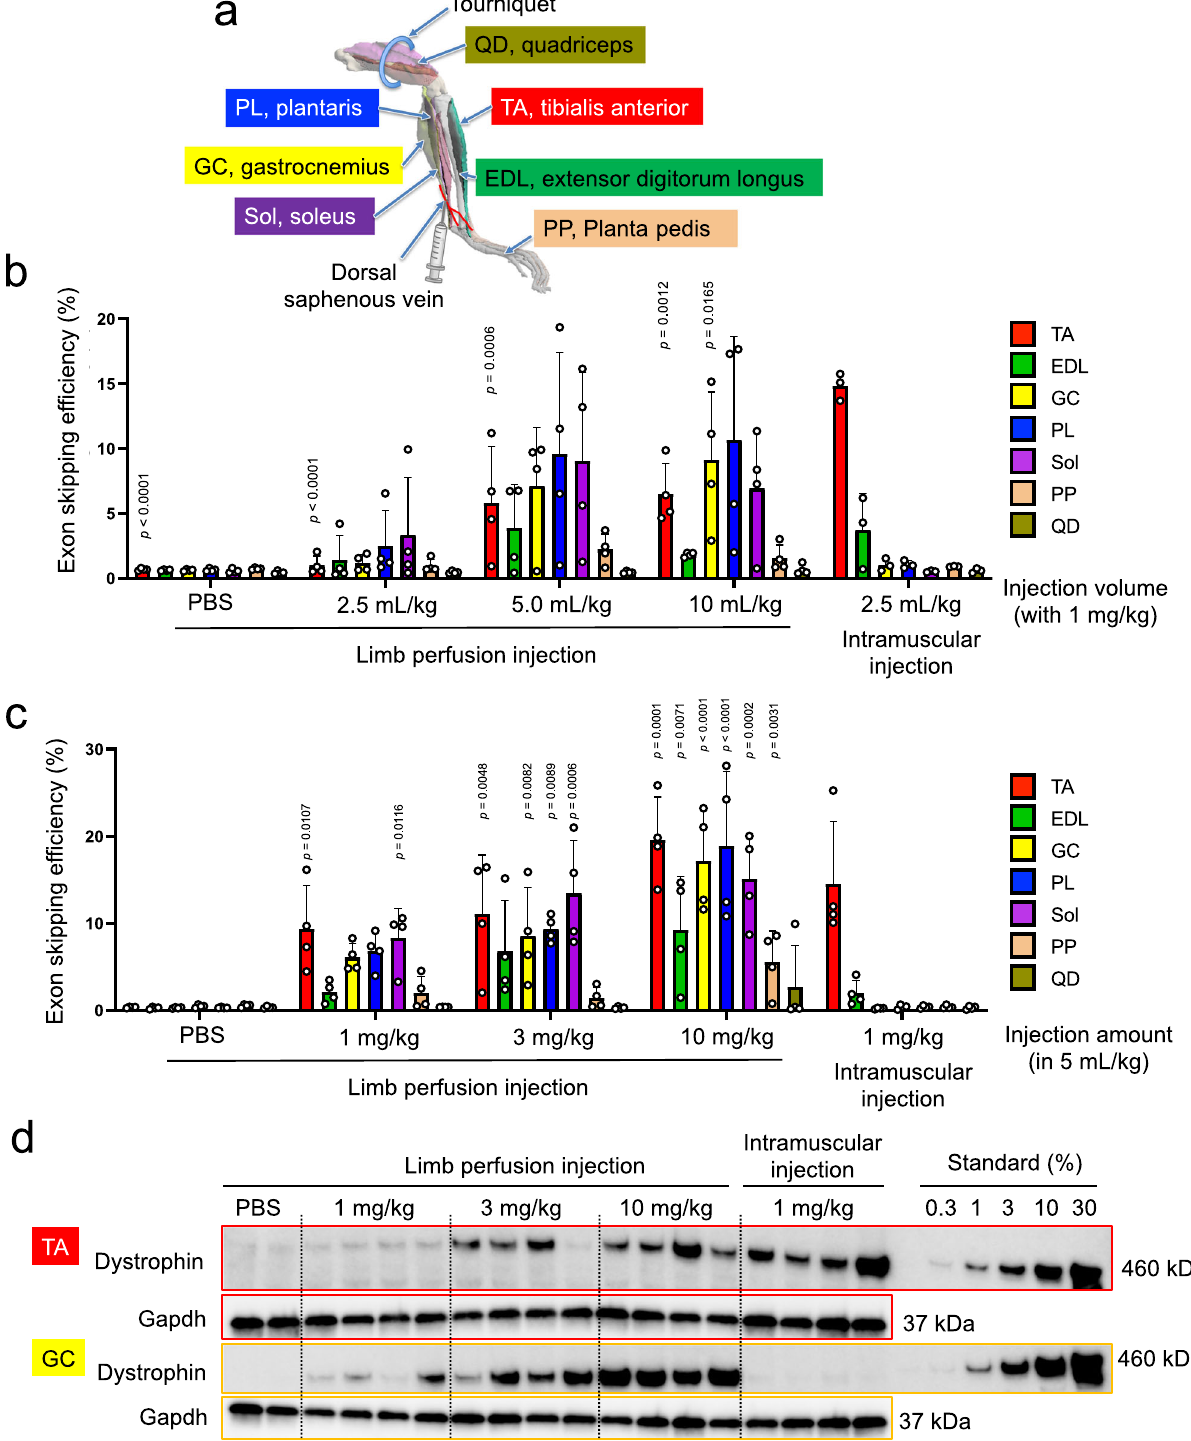
Fig. 6 Intravenous delivery of LNP-Cas9/sgRNA by limb perfusion. a Schematic illustration of mouse hindlimb and relevant muscle groups. The 3D model of hindlimb is adapted from ref. 50 . LNP-CRISPR was injected into the dorsal saphenous vein. b Effect of the injection volume (2.5 – 10 mL/kg) on exon skipping ef fi ciency in each muscle group of the lower hindlimb following limb perfusion of LNP-CRISPR in hEx45-mdx44 mice. TA tibialis anterior, EDL extensor digitorum longus, GC gastrocnemius, PL plantaris, Sol soleus, PP planta pedis, QD quadriceps. Data are represented as means ± S.D. ( n = 4 mice for limb perfusion injection groups, n = 3 mice for intramuscular injection group). p value by two-sided Dunnett ’ s test showed signi fi cantly different from intramuscular injection (2.5 mL/kg) in the same skeletal muscle. c Effect of the injection dose (1 – 10 mg/kg) of total RNA packaged in LNP under 5 mL/kg injection volume. Data are represented as means ± S.D. ( n = 4 mice). p value by two-sided Williams ’ test showed signi fi cantly different from limb perfusion-PBS of the same skeletal muscle. d Dose-dependent dystrophin restoration in TA and GC following 14 days of limb perfusion of LNP-CRISPR ( n = 4 mice for each LNP injection group, n = 2 mice for PBS injection